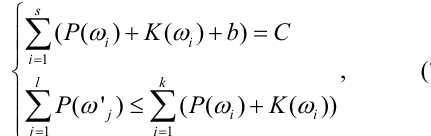
Fig. 1. Description of our joint visual attention